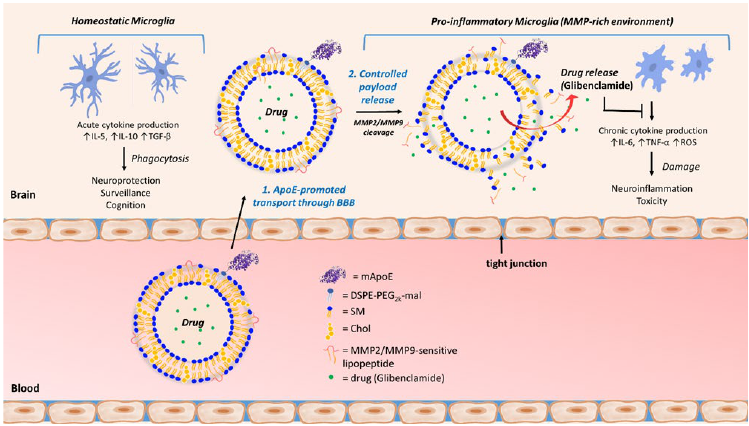
Figure 1. CNS-targeted multifunctional liposomes useful (1) to promote drug brain bioavailability, by mApoE-induced transport through the BBB; and (2) to promote specific and controlled release of loaded, poorly bioavailable neuroprotective drugs by MMPs-sensitive lipopeptides.